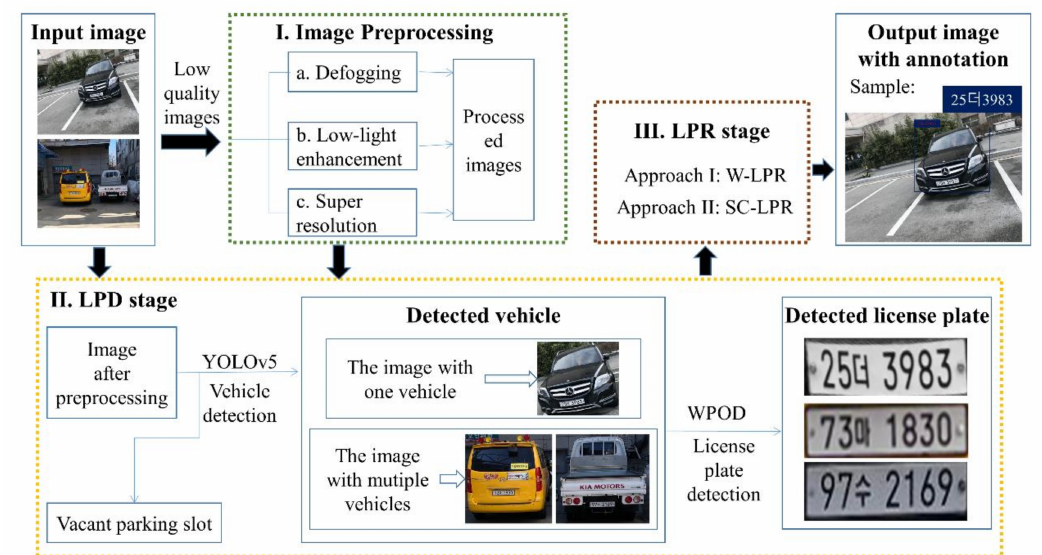
Figure 2. The flowchart of the LPR system from the input image to the labeled output image is divided into three parts, which include image preprocessing, LPD, and